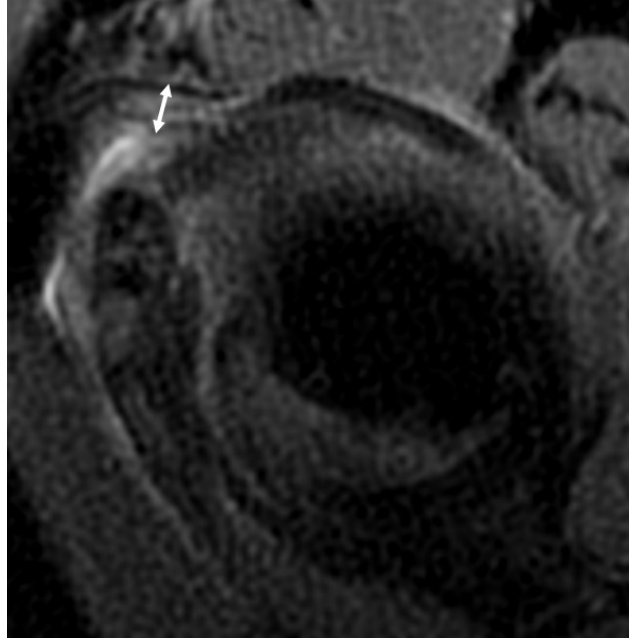
Figure 3. Sagittal oblique non-contrast fat-suppressed T2-weighted fast spin-echo MRI of the left shoulder in a 55-year-old man with adhesive capsulitis shows method used to measure coracohumeral ligament thickness (double white arrow) (4 mm). Additionally, note its high signal intensity.